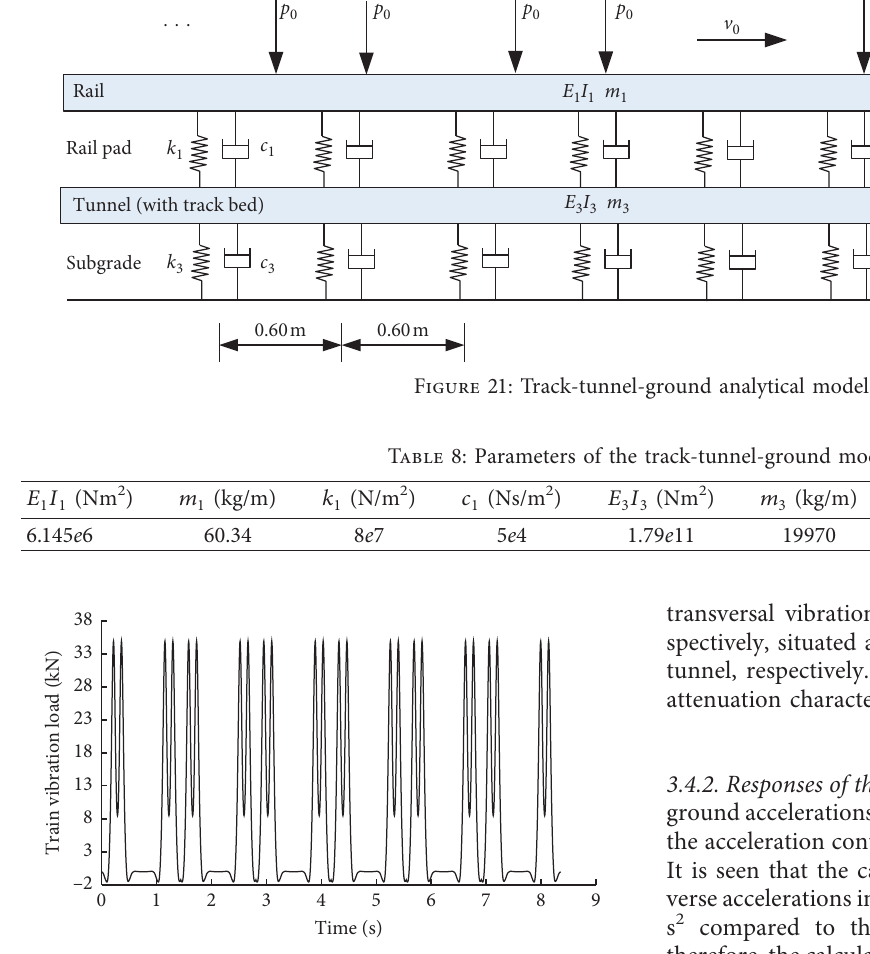
Figure 22: Time history of the train vibration load on the track